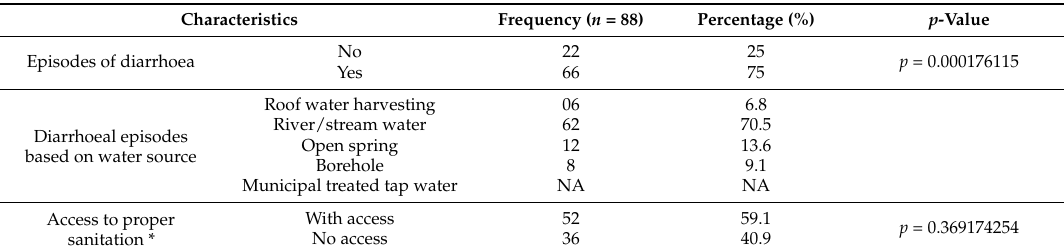
Table 2. Episodes of diarrhoea prior to HWTS implementation and water and sanitation per household in Makwane Village.